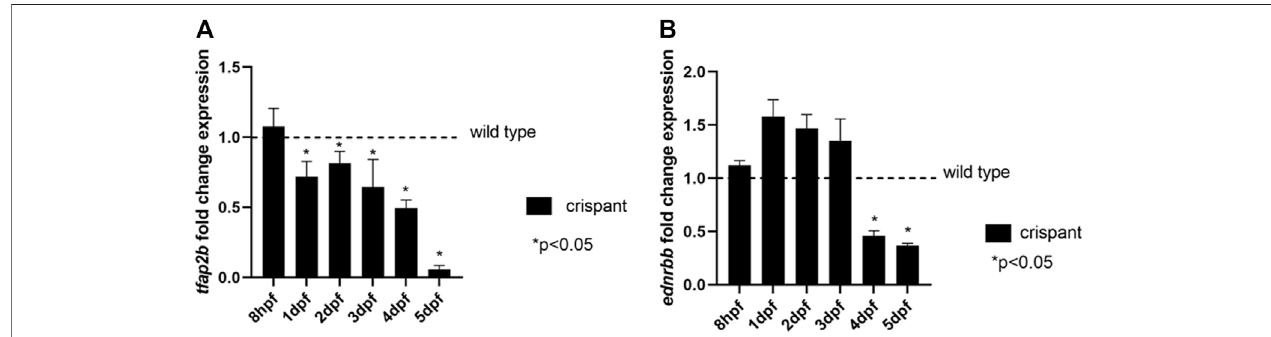
FIGURE4| Expressionlevelsof tfap2b and ednrbb duringzebra fi shdevelopment. (A) Expressionlevelsof tfap2b incrispant fi shat8 hpf,1,2,3,4,and5 dpfshow a signi fi cant decrease when compared to wild type, starting from 1 dpf onwards ( p < 0.05, unpaired t -test). (B) Expression levels of ednrbb in tfap2b crispants show a signi fi cant decrease when compared to wild type fi sh, at 4 and 5 dpf ( p < 0.05, unpaired t -test).